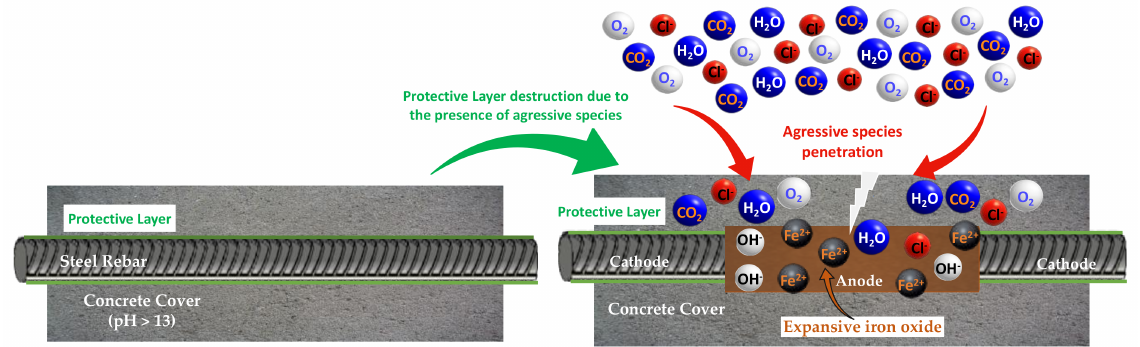
Figure 1. Electrochemical corrosion process on the concrete surface